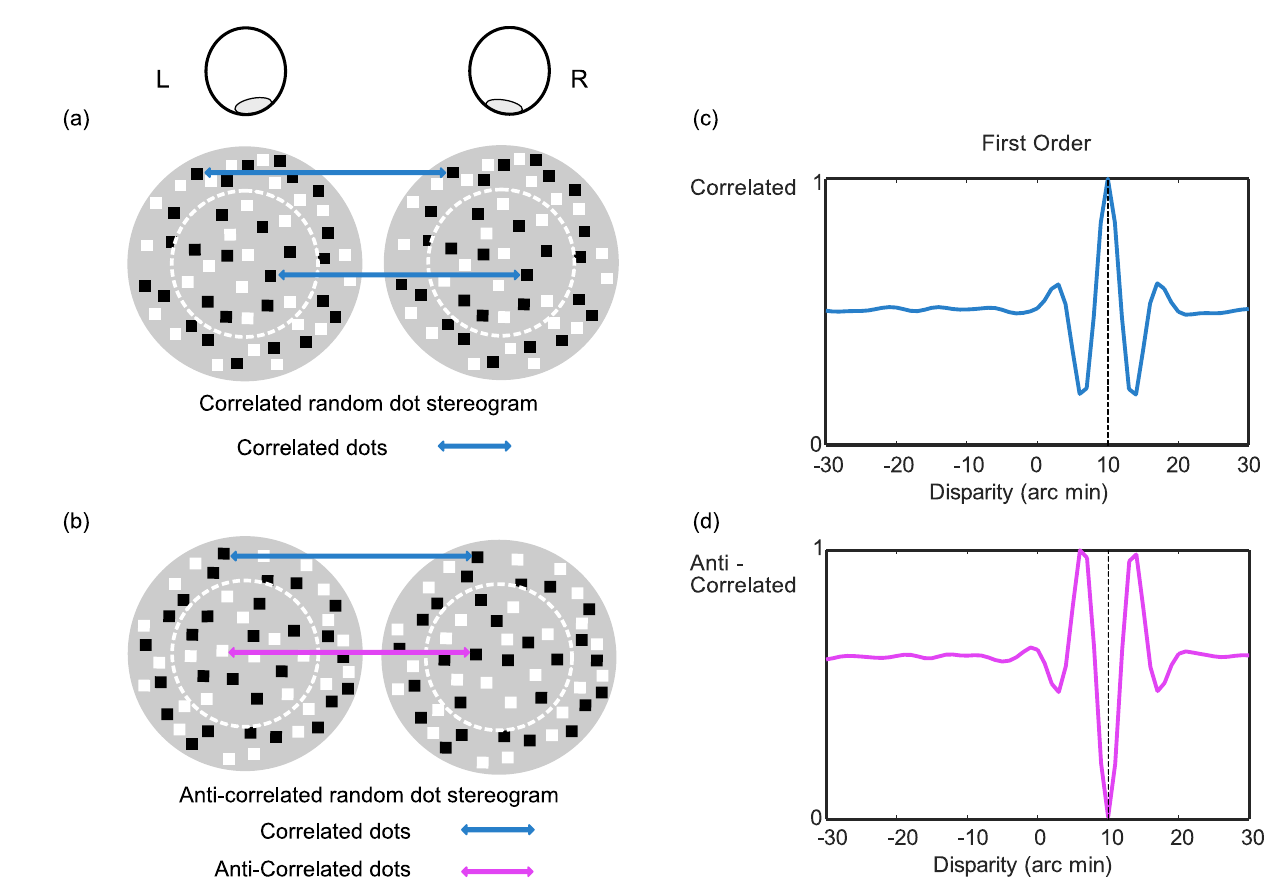
Fig 3. (a) Image pair for a correlated random dot stereogram, where the outer annulus and the inner circle (the detection target) contain correlated (matching) dots in the images shown to the left and right eyes. (b) Image pair for an anticorrelated random dot stereogram, where the outer annulus contains correlated (matching) dots in the images shown to the left and right eyes. In contrast to the correlated target in (a), the target circle contains anticorrelated (reversed polarity) dots in the images shown to the left and right eye. (c) an example first order binocular energy tuning function in response to a correlated random dot stereogram. This tuning function has a preferred disparity at 10 arc minutes (d) the same first order binocular energy tuning function in response to an anticorrelated random dot stereogram. The tuning function is inverted and now has a preferred disparity at 5 arc